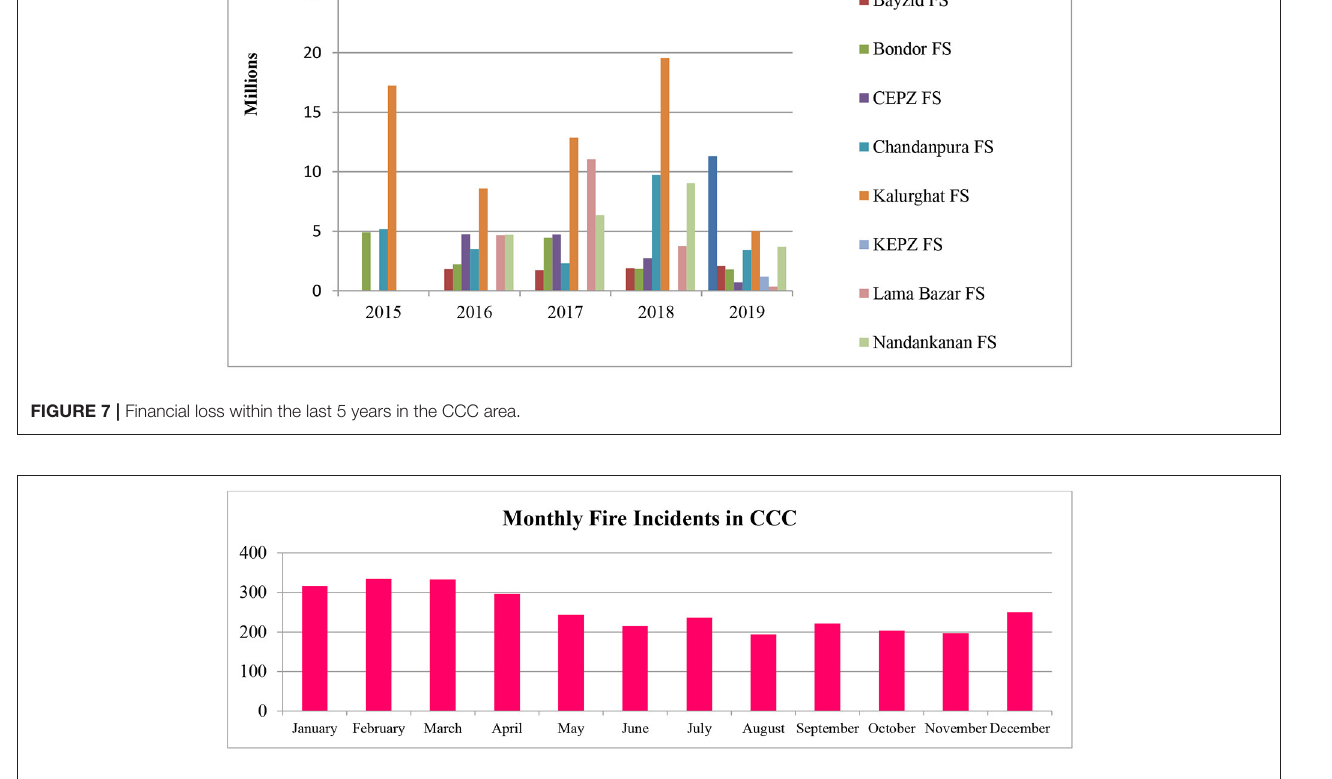
FIGURE 8 | Monthly total number of fire incidents in the CCC area.